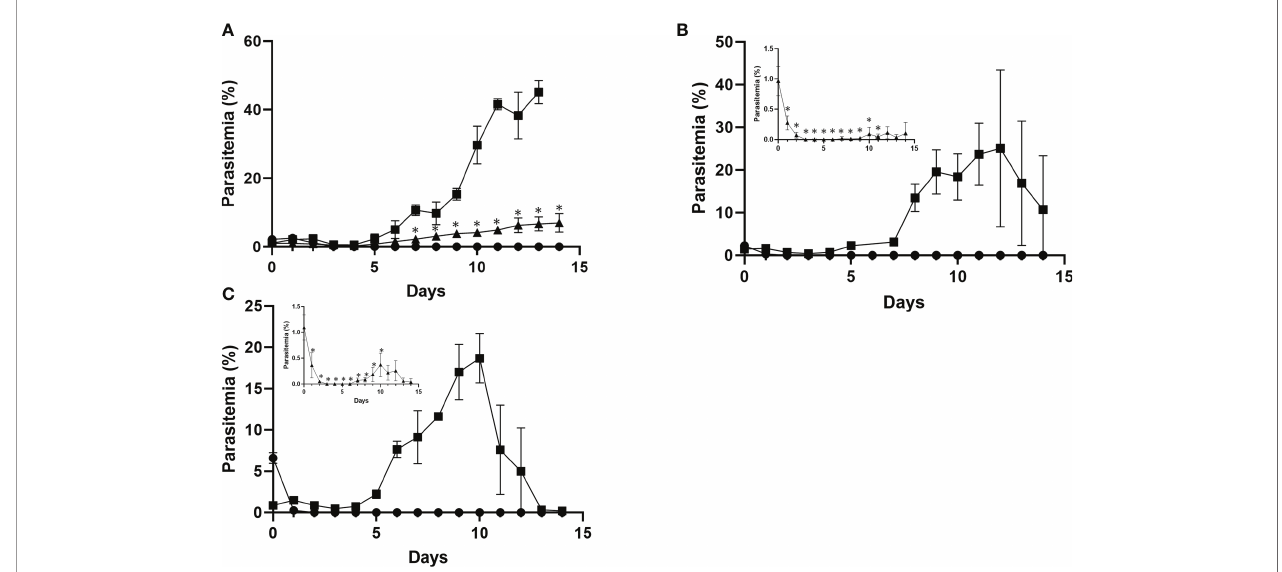
FIGURE 4 | Comparison of PPQ susceptibility among PbCRT-N331I, PbMut-PPQ-R-P9, and PbWT parasites. Three clones of PbMut-PPQ-R-P9 (closed square) or PbCRT-N331I (closed triangle) were intravenously inoculated into three BALB/c mice each. PbWT parasites (closed circle) were injected into nine mice. Three mice in each group were then treated with PPQ at doses of 5, 15, and 30 mg/kg/day (A – C) for fi ve consecutive days starting on day 0. The parasitemia of PbCRT-N331I is shown in the insets of (B, C) because of low parasitemia. As shown in (A) , the parasitemia of PbMut-PPQ-R-P9 on day 14 was not determined because the mice died due to high parasitemia. The bar represents the standard deviation. The asterisks indicate that the parasitemia of PbCRT-N331I was signi fi cantly different from that of PbMut-PPQ-R-P9